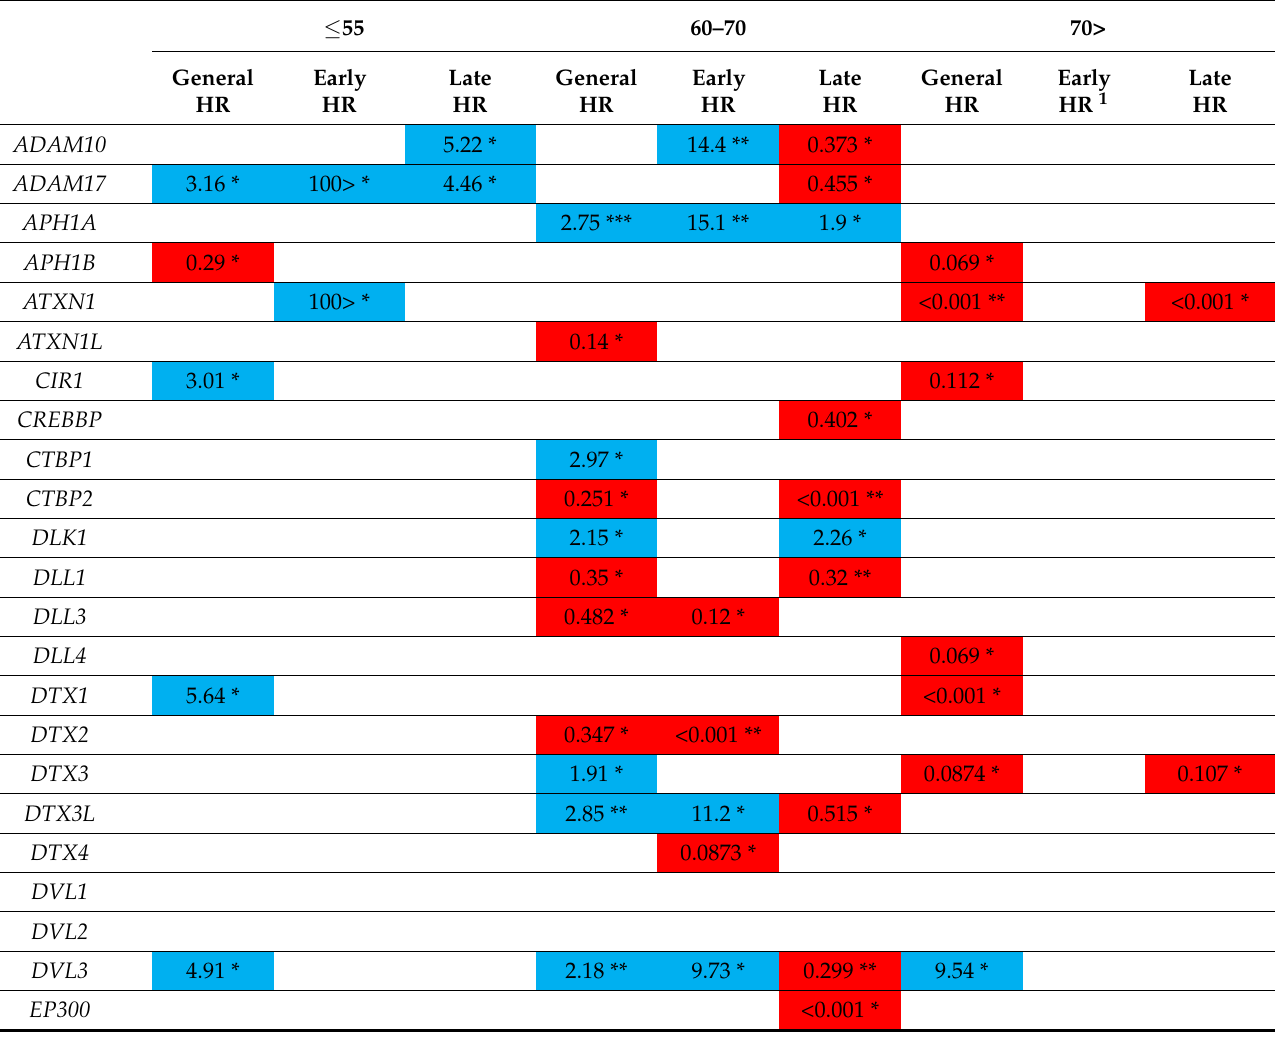
Table 3. The core participants of the Notch pathway differentiate DFS according to patients’ age and stage of the disease. The number represents the hazard ratio (HR) and the color indicates the trend–the blue color indicates that lower expression (i.e., below the determined cutpoint) was more favorable, and the red indicates that higher expression (i.e., above the determined cutpoint) was more favorable regarding DFS prognosis. Legend: 1 All patients were tumor-free; * p < 0.05, ** p < 0.01, *** p <